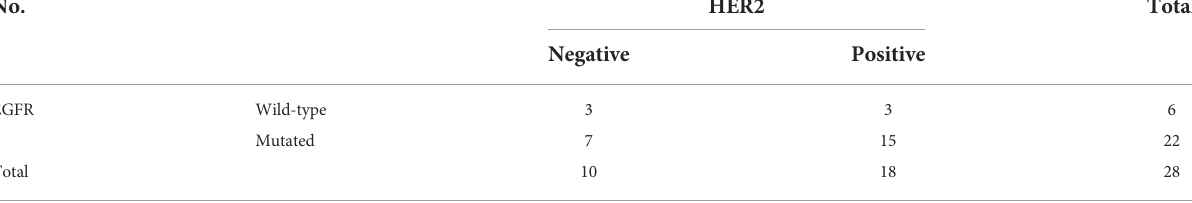
TABLE 2C Correlation of EGFR mutation and HER2 status of breast cancer.